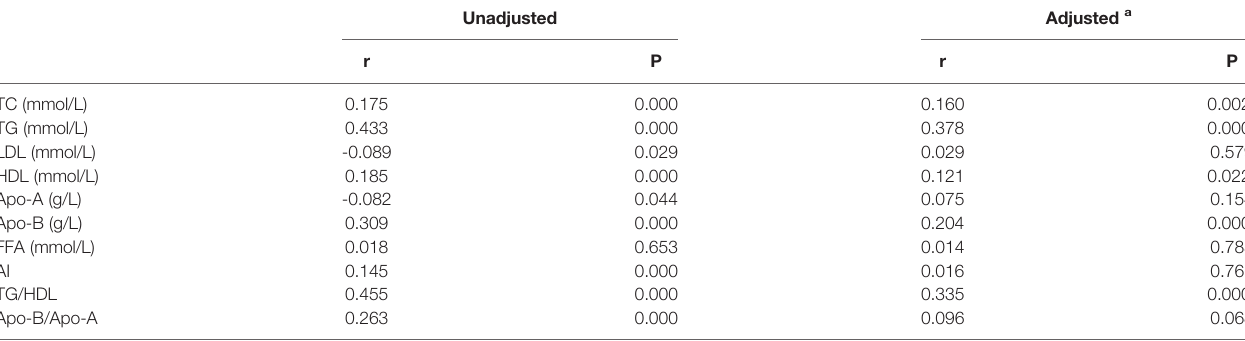
TABLE 4 | Correlations between lipid parameters and HOMA-IR in PCOS